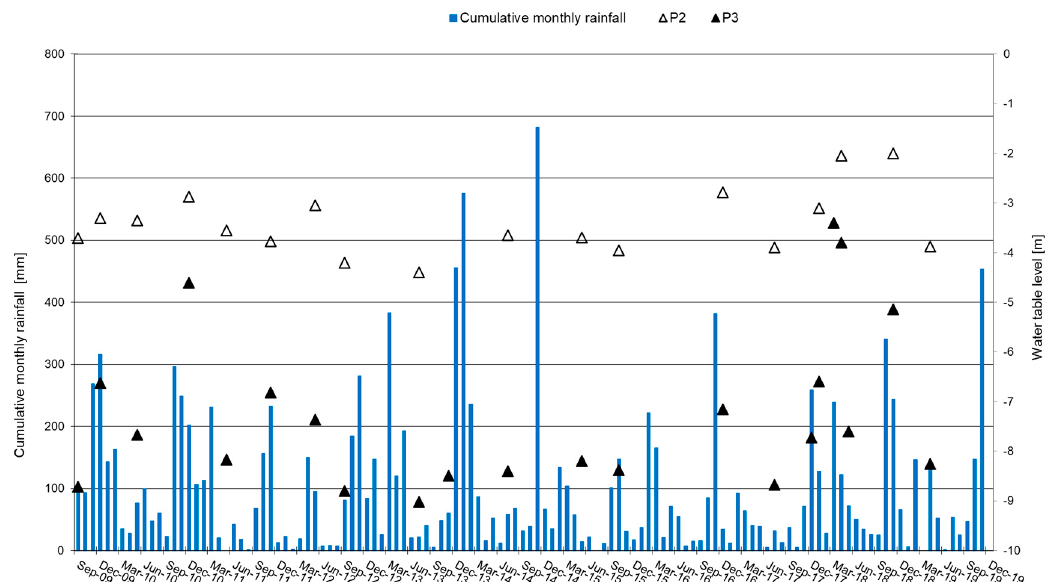
Figure 8. Cumulative monthly rainfall and water table level (from the ground surface) at P2 and P3.